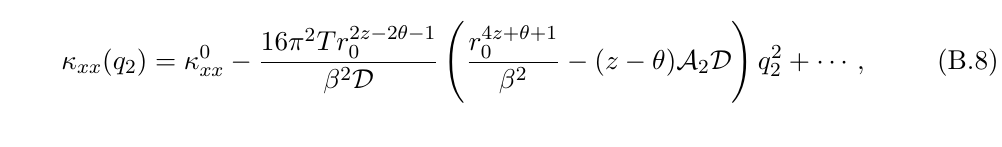
Figure 25 and (cid:12)gure 26 show the density dependence of Nernst signal and Seebeck coe(cid:14)cient respectively, which are related to the thermoelectric conductivity (cid:11) . We can